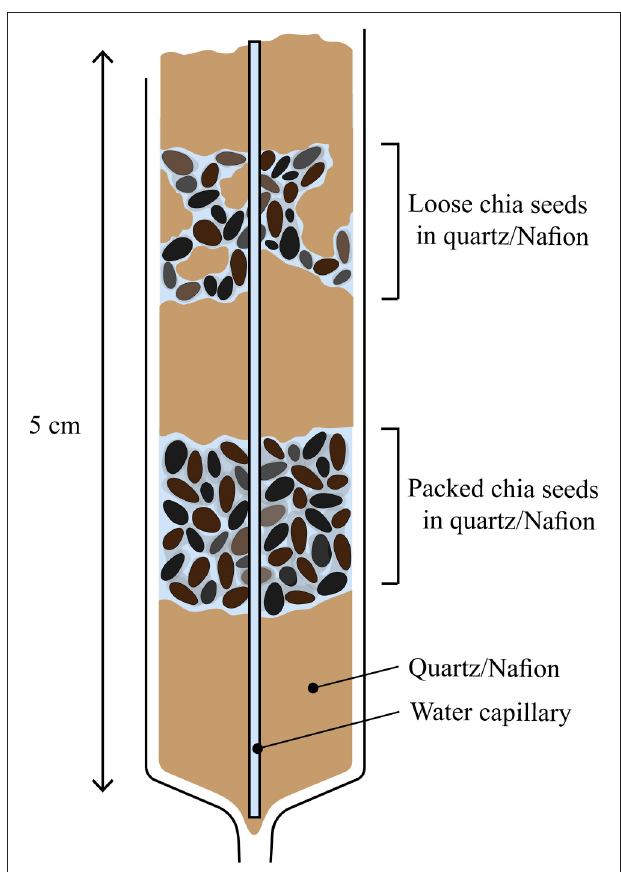
FIGURE 1 | Sample design of chia in Nafion and